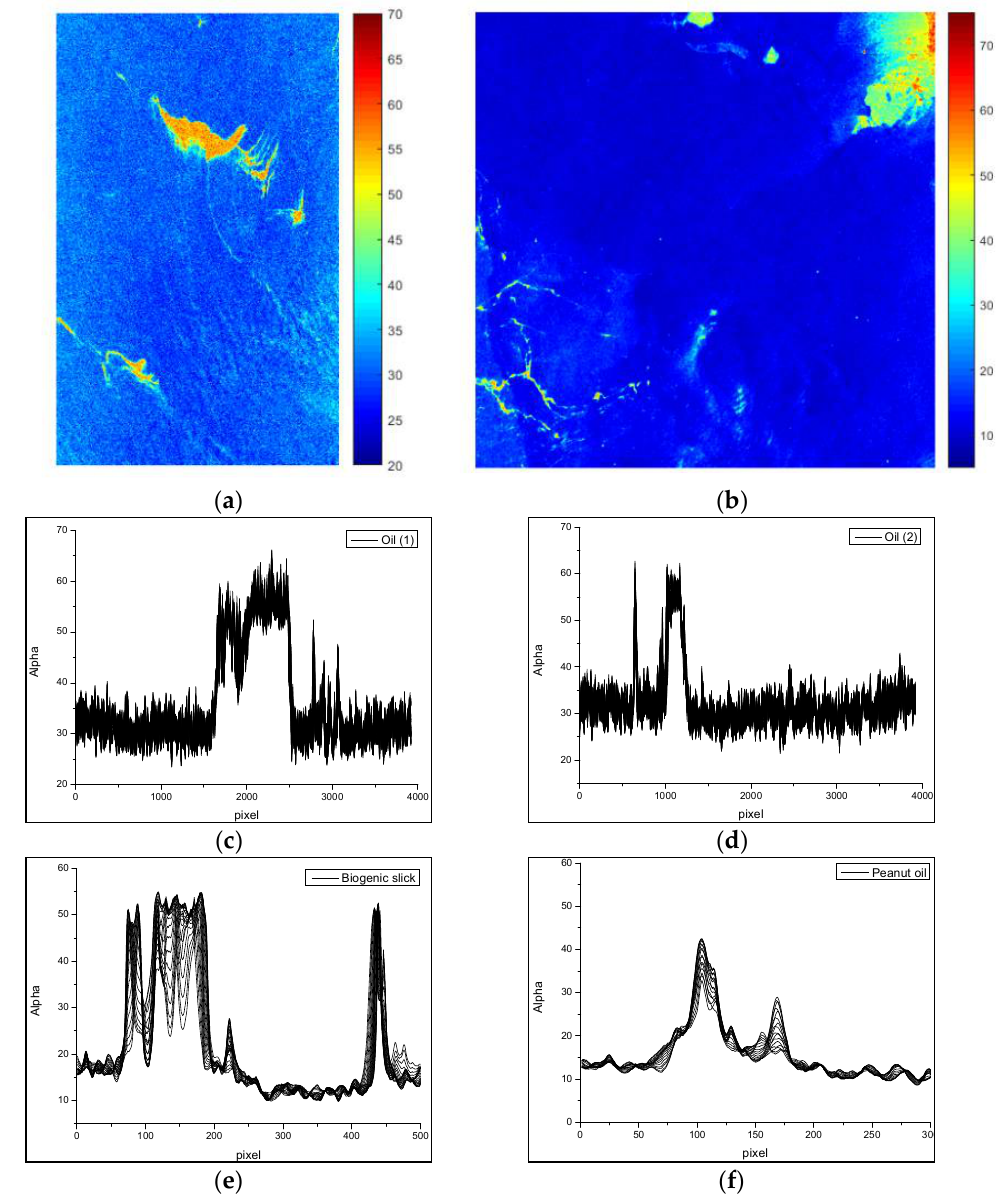
Figure 6. Mean scattering angle (α) for the two continuous slow-release slicks cases mentioned above: ( a ) Case 1; ( b ) Case 2; ( c – f ) the mean scattering angle for the four green rectangular areas (oil (1), oil (2), biogenic slick, and peanut oil, respectively) that are indicated on the SAR images in Figures 2 and 3.